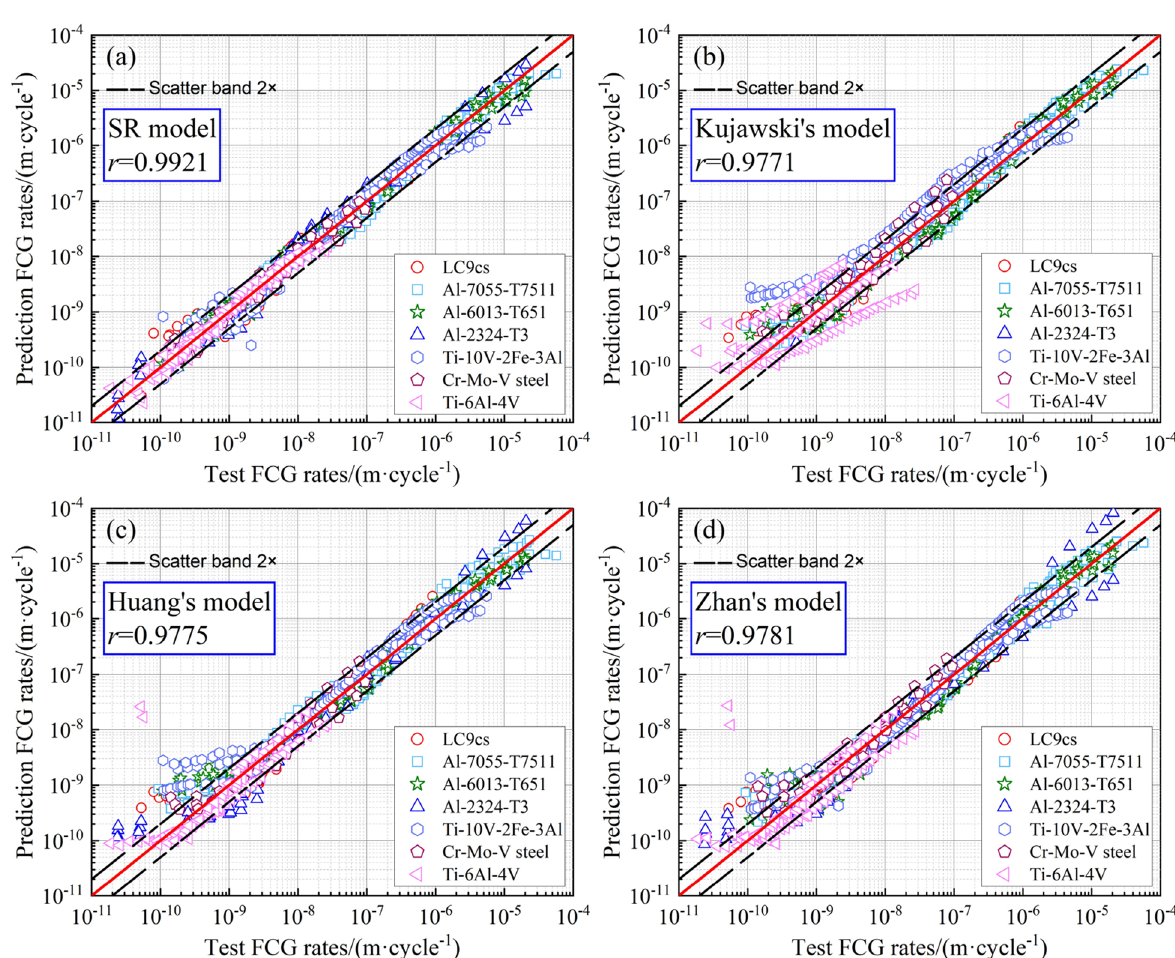
Figure 9 FCG rates based on four models between the SR model and test data: a SR model, b Kujawski’s model, c Huang’s model, d Zhan’s